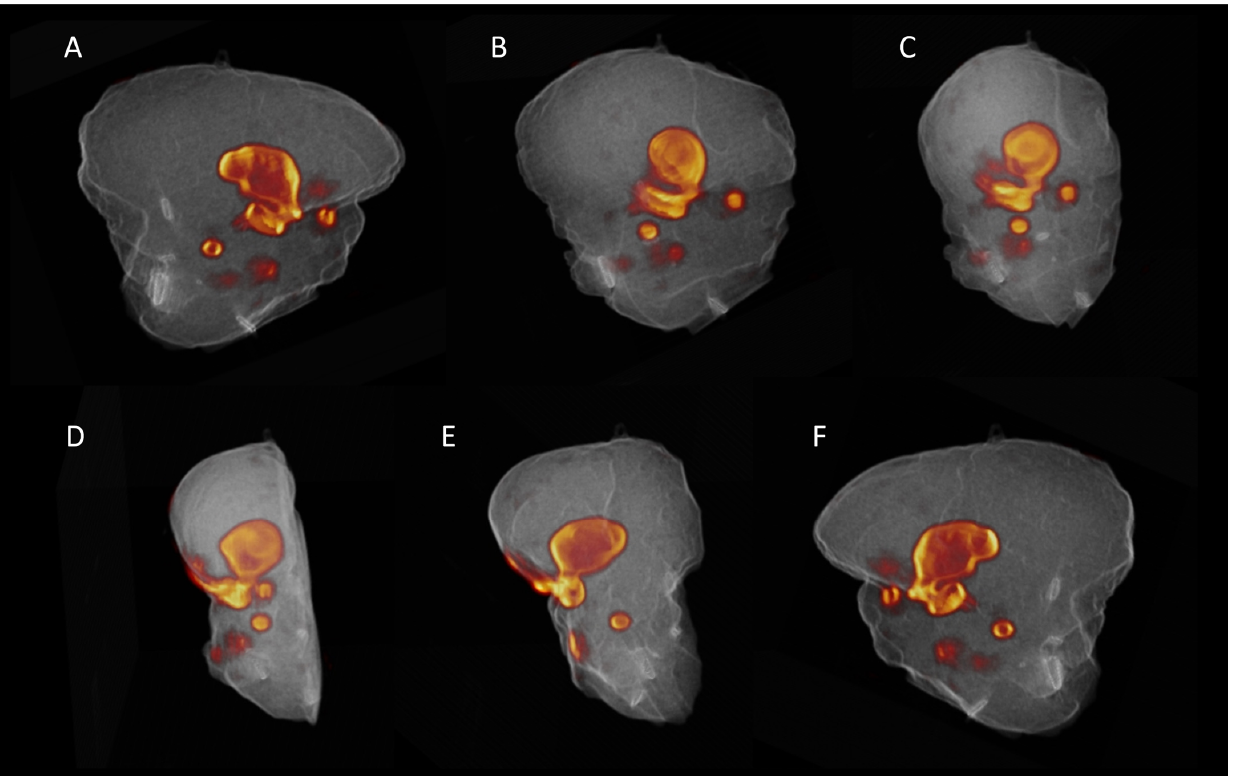
Figure 2. Three-dimensional render of the PET/CT-imaging results of the scanned specimen from patient 2. These images display a 3D-render of the imaging results collected by scanning a hemiglossectomy caused by a malignant squamous cell carcinoma in the tongue after 18 F-FDG administration. From A-F the rendering is stepways rotated for 180° around the z-axis to provide full insight in the exact location of the 18 F-FDG uptake within the scanned specimen. The imaging results hence display the proposed location of the malignancy and both superficial and deep tumor margins within the resected specimen. The full animation is provided in Supplementary Material 2.